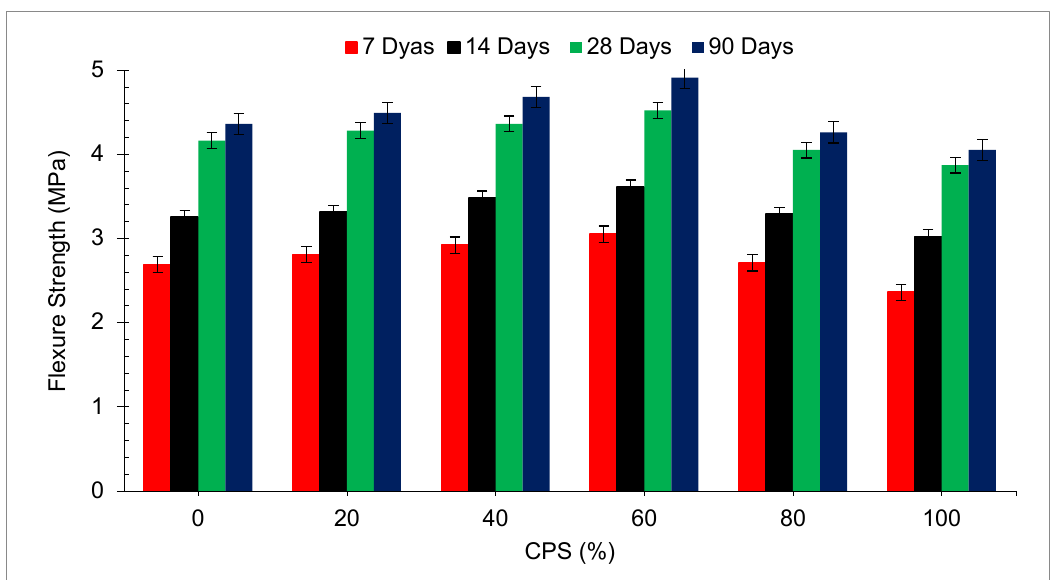
Figure 12. Flexural strength of concrete: data source [45].